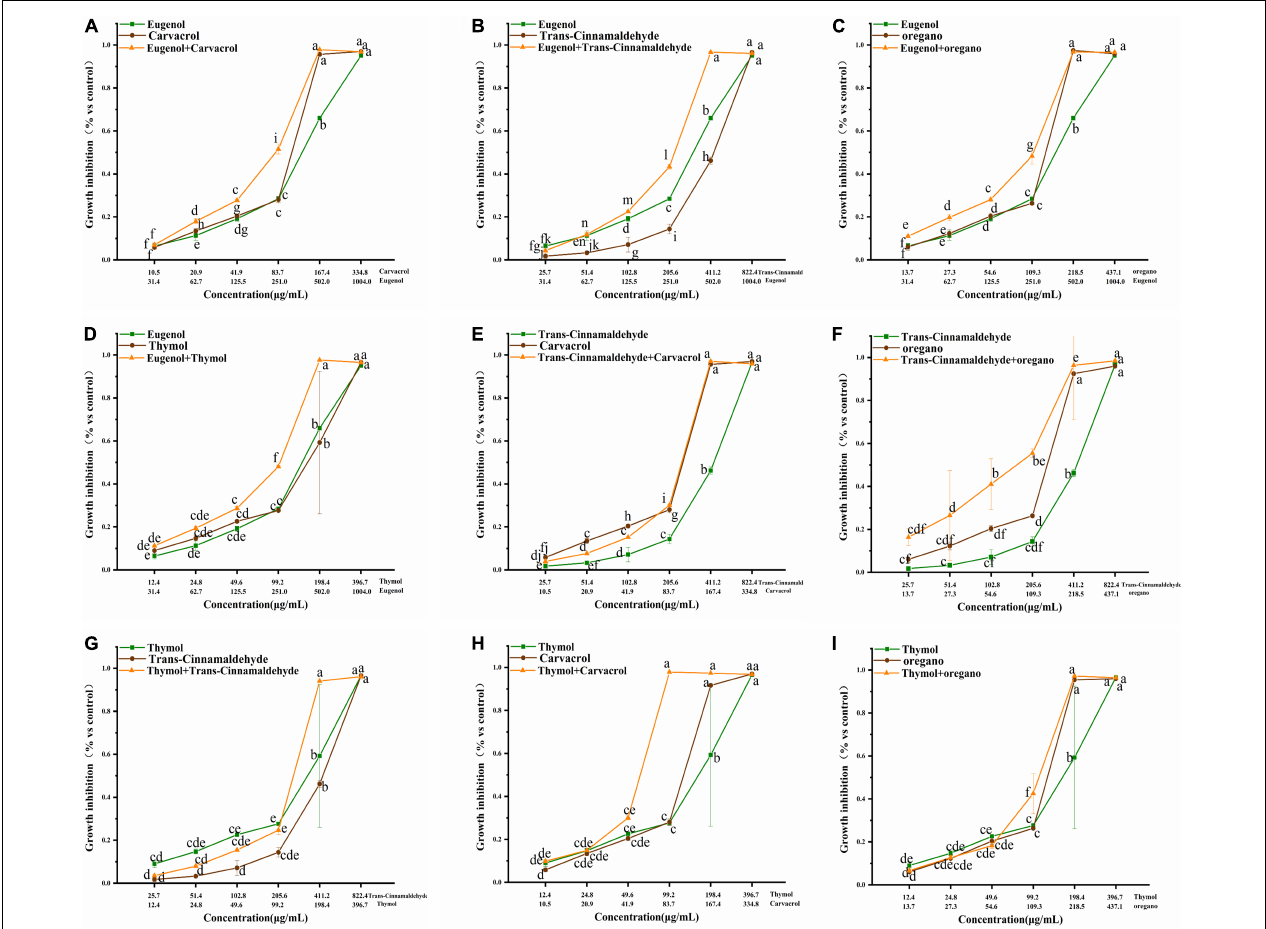
FIGURE 3 | (A–I) Effect of single and combined of natural antimicrobials on the growth inhibition rate of Klebsiella pneumoniae sample 208G28. Note: The significant differences among different concentrations or individual and combinations were analyzed using one-way ANOVA, followed by Duncan multiple comparisons ( P < 0.05 represents significant differences). The differences between various concentrations and groups are marked by letters: the same letters represent no differences, while different letters indicate significant